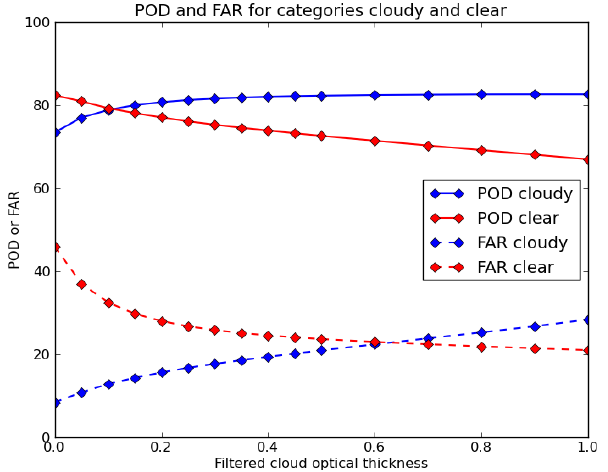
Fig. 6. Same visualisation as in Fig. 4 but for the hit rate and Kuiper’s skill